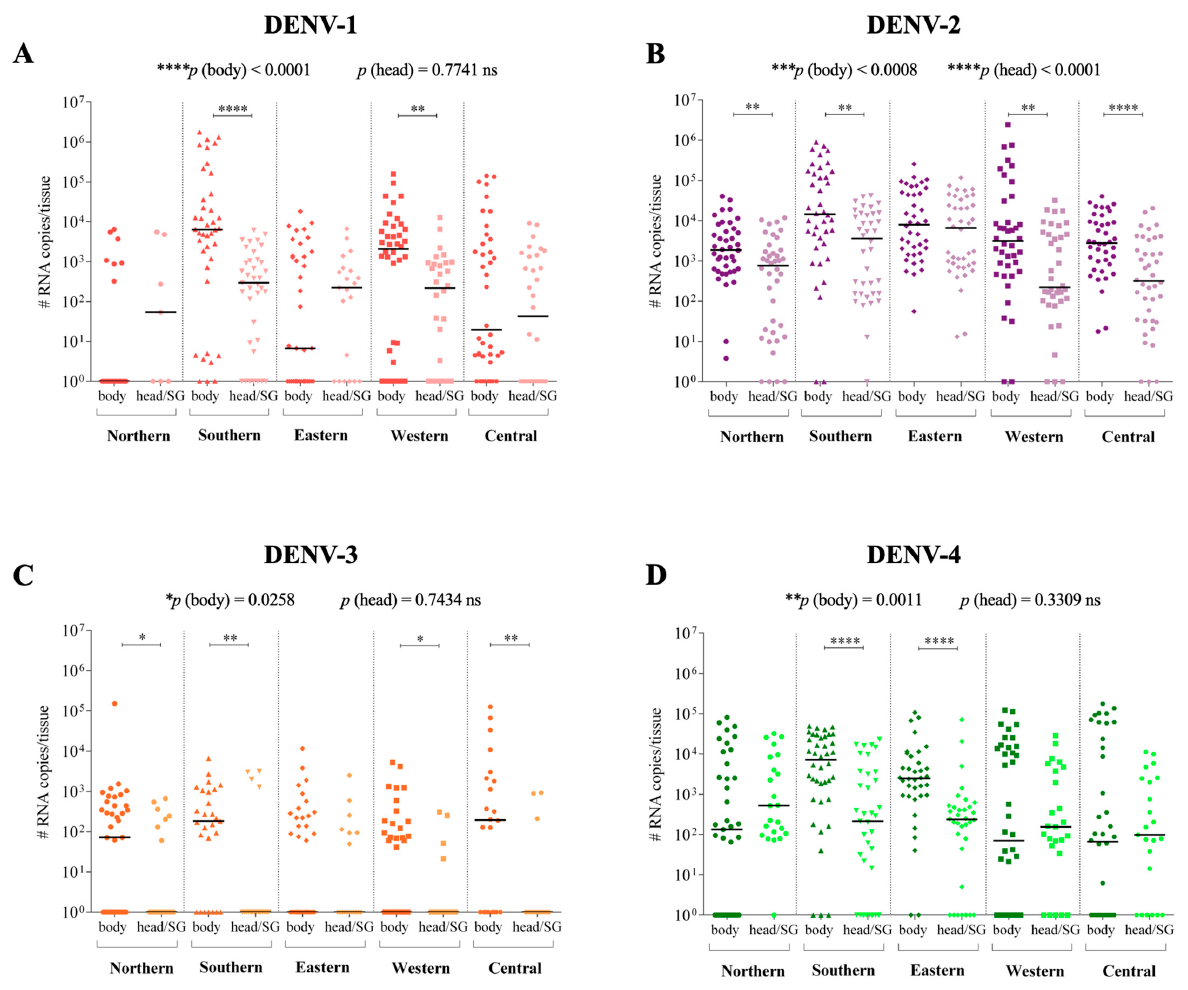
Figure 3. Body and head/SG viral loads of five Ae. aegypti populations from different districts of the municipality of Manaus, Brazil after infection with DENV-1 ( A ), DENV-2 ( B ), DENV-3 ( C ), and DENV-4 ( D ). p values > 0.05 [non-significant (ns)] are not represented. p values ≤ 0.05, ≤ 0.01, ≤ 0.001, and ≤ 0.0001 are summarized with one (*), two (**), three (***), and four (****) asterisks, respectively.